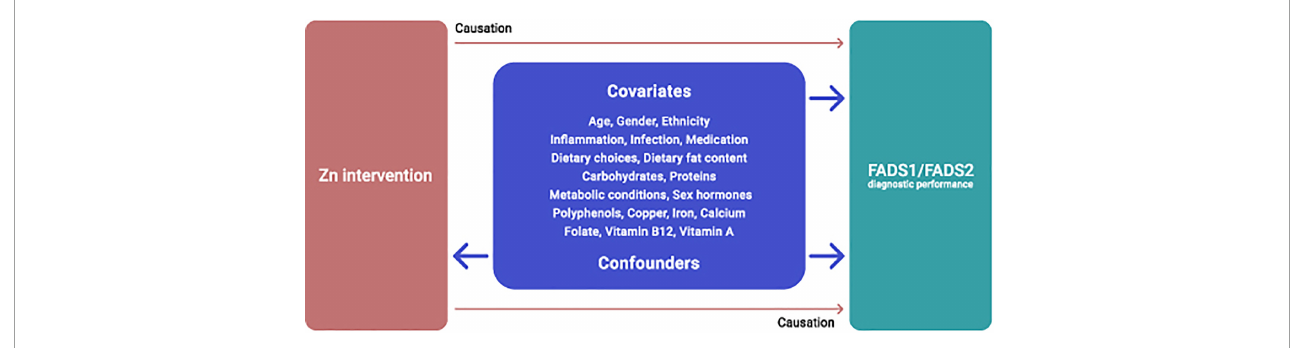
FIGURE4 Potential covariates and confounders of dietary Zn intervention and FADS1/FADS2 interrelations.